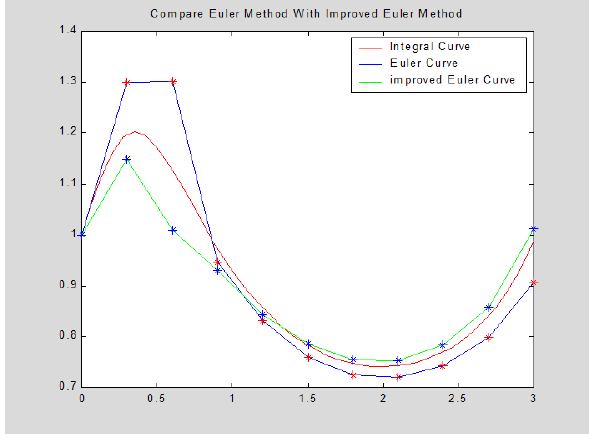
Fig. 3 Comparison of the Euler method and modified Euler